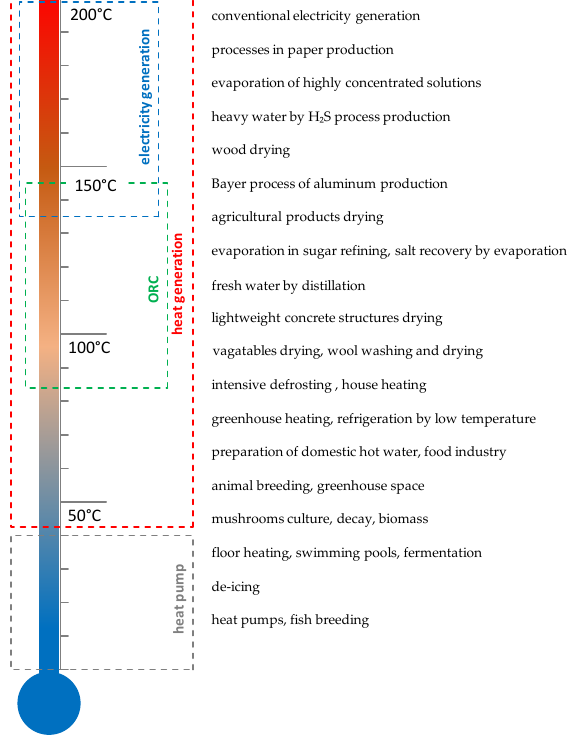
Figure 1. Modified Lindal diagram. Source: own study, based on [9,10].